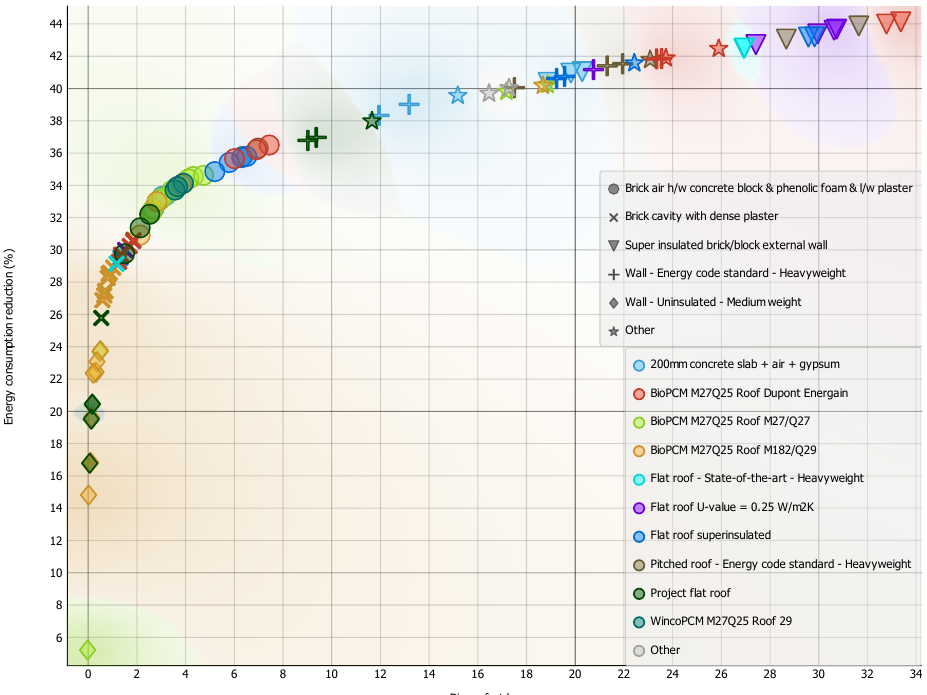
Figure 8. Results of energy consumption reduction (%) for cooling at Pareto’s front for the H060.